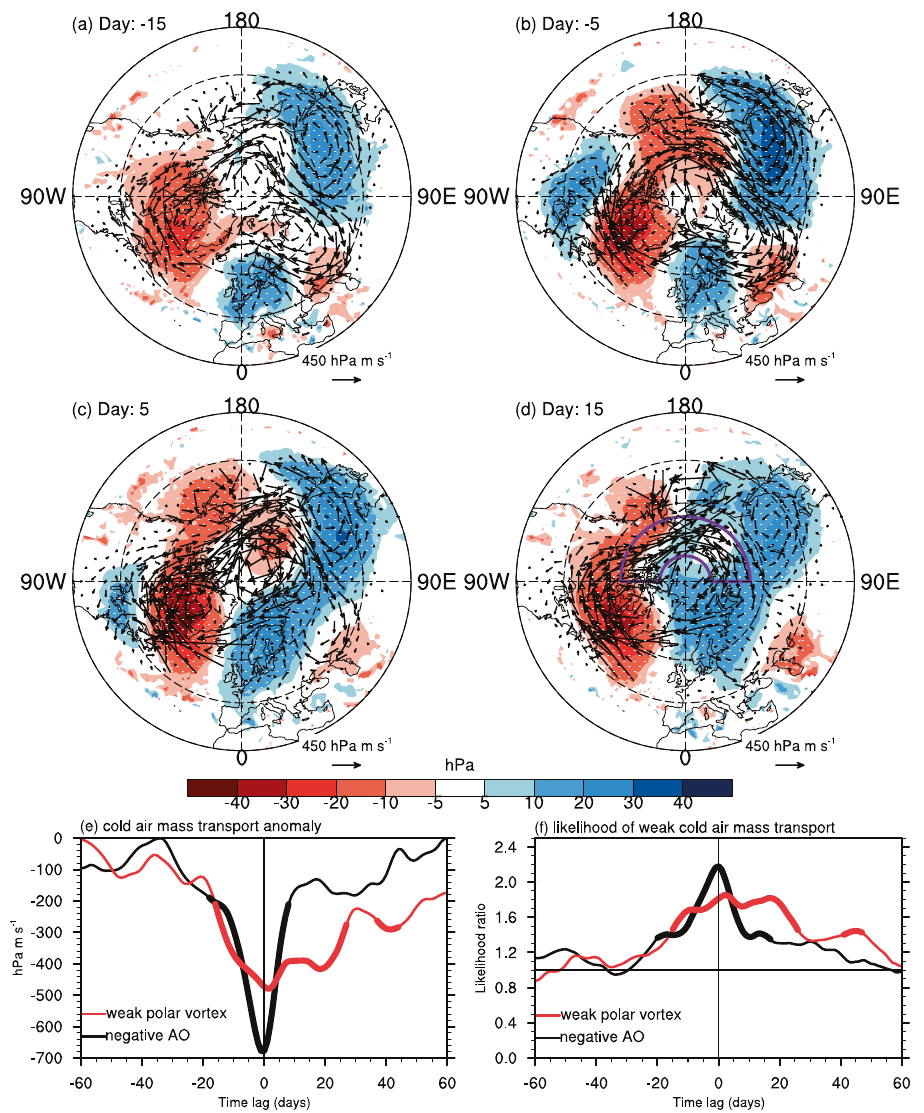
Fig. 4 The weakened inter-hemispheric transport of cold air mass related to a weak polar vortex. The composited geographical distributions of the anomalous cold air mass amount (shading; hPa) below the 280 K isentropic surface and their horizontal fl ux (arrows; hPa m s − 1 ) 15 days before ( a ), 5 days before ( b ), 5 days after ( c ), and 15 days after ( d ) weak polar vortex conditions obtained from the JRA-55 reanalysis dataset. Stippling indicates that the anomalies are statistically signi fi cant at a 95% con fi dence level based on a two-sided Student ’ s t test. The purple box in ( d ) indicates the area used to calculate the inter-hemispheric transport of cold air mass. Note that cold color means anomalous high cold air mass and warm color means anomalous low cold air mass. e The time-lagged composite of anomalous inter-hemispheric cold air mass transport under weak polar vortex (red curve) and negative AO (black curve) conditions. The inter-hemispheric cold air mass transport has a climatological value of ~350 hPa m s − 1 . f The time-lagged likelihood of the weakened inter-hemispheric cold air mass transport under weak polar vortex (red curve) and negative AO (black curve) conditions. The de fi nitions of positive and negative lags are the same as shown in Fig. 2. The thick line segments in ( e ) and ( f ) indicate that the composited anomaly and the likelihood, respectively, are statistically signi fi cant at a 95% con fi dence level based on 1000-time bootstrap samples with